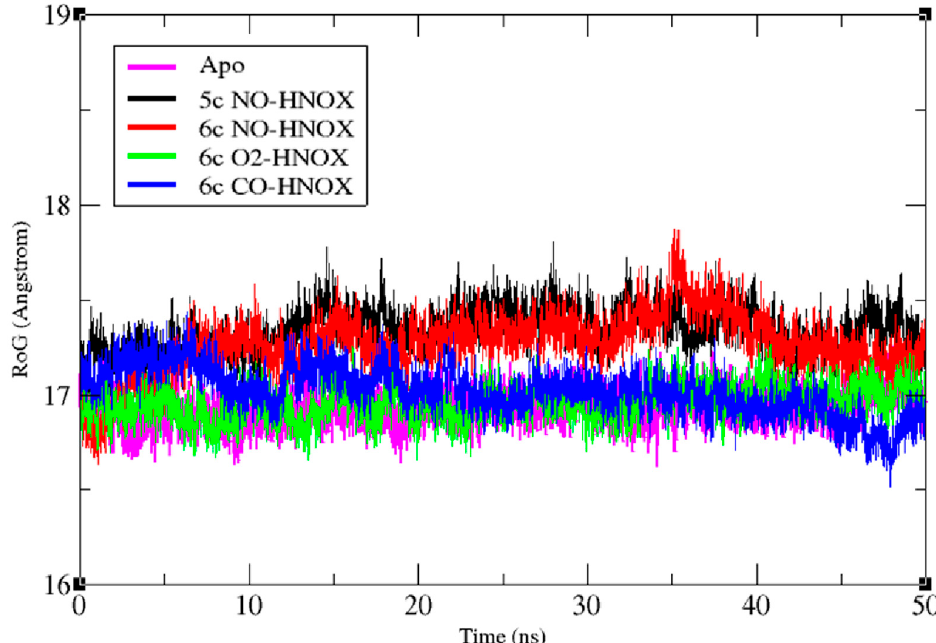
Figure 5. Time-dependent plot of the radius of gyration (R g ) for apo, 6c NO/CO/O 2 -HNOX and 5c NO-HNOX systems. Magenta, black, red, green and blue represent the plots of apo, 5c NO-HNOX, 6c NO-HNOX, 6c O 2 -HNOX, and 6c CO-HNOX, respectively.